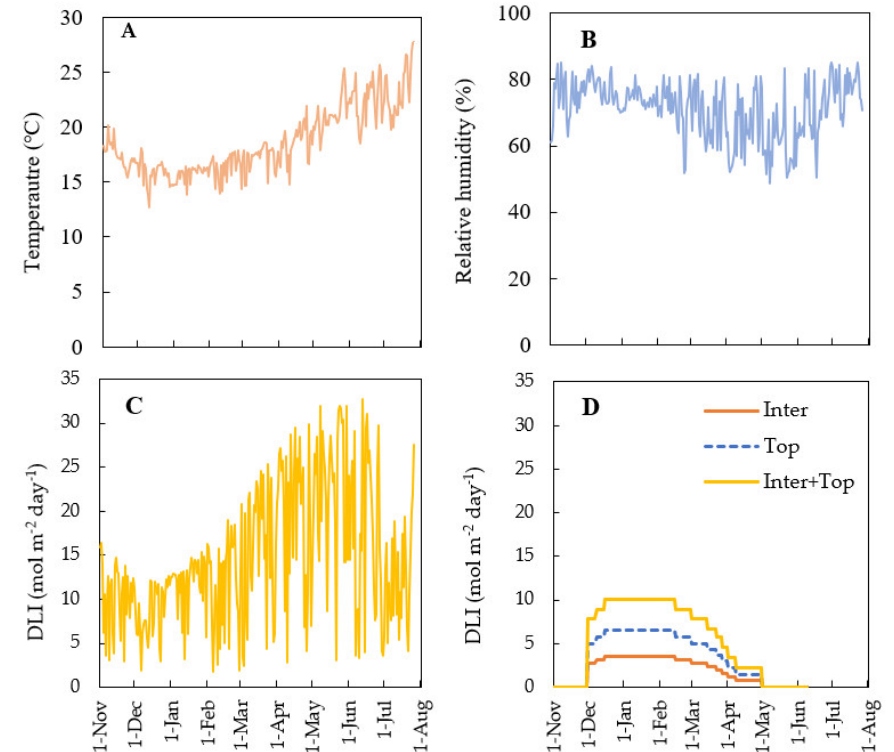
Figure 2. Greenhouse environmental conditions: ( A ) daily mean temperature, ( B ) relative humidity, ( C ) natural daily light integral, ( D ) daily light integral with LED supplemental lighting.